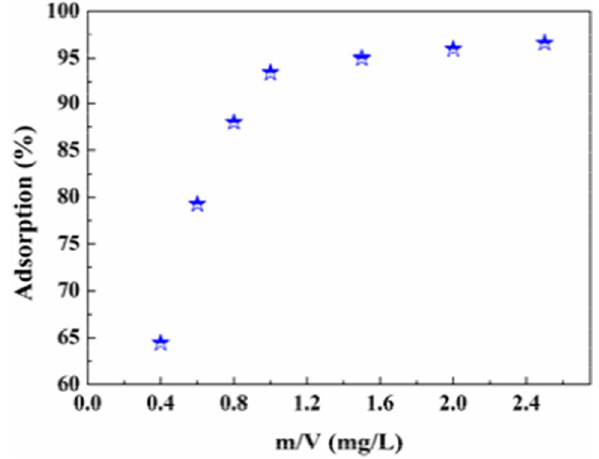
Fig. 3 Adsorption percentage of Pb2 + on 3D AFC as a func- tion of solid content. [Pb2 +]0 = 4.8 × 10–4 mol/L, pH = 5.5 ± 0.1, I = 0.001 M NaCl, T = 25